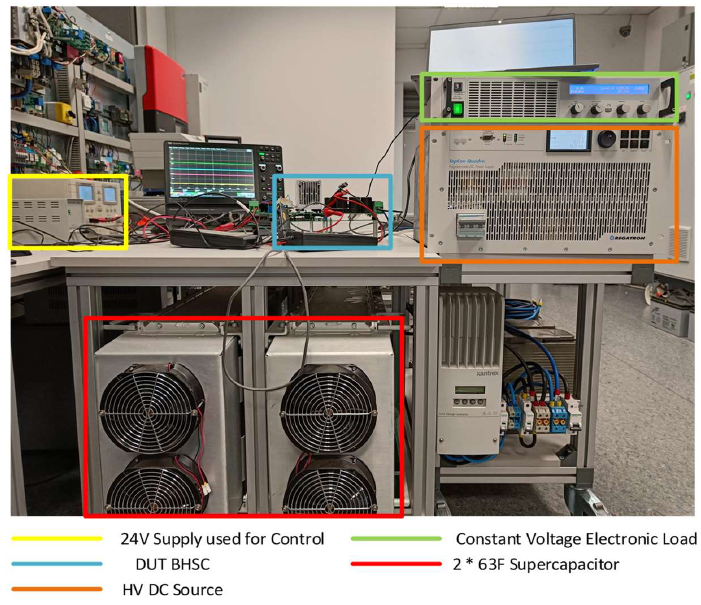
Figure 25. A picture of the experimental setup used for BHSC prototype testing.